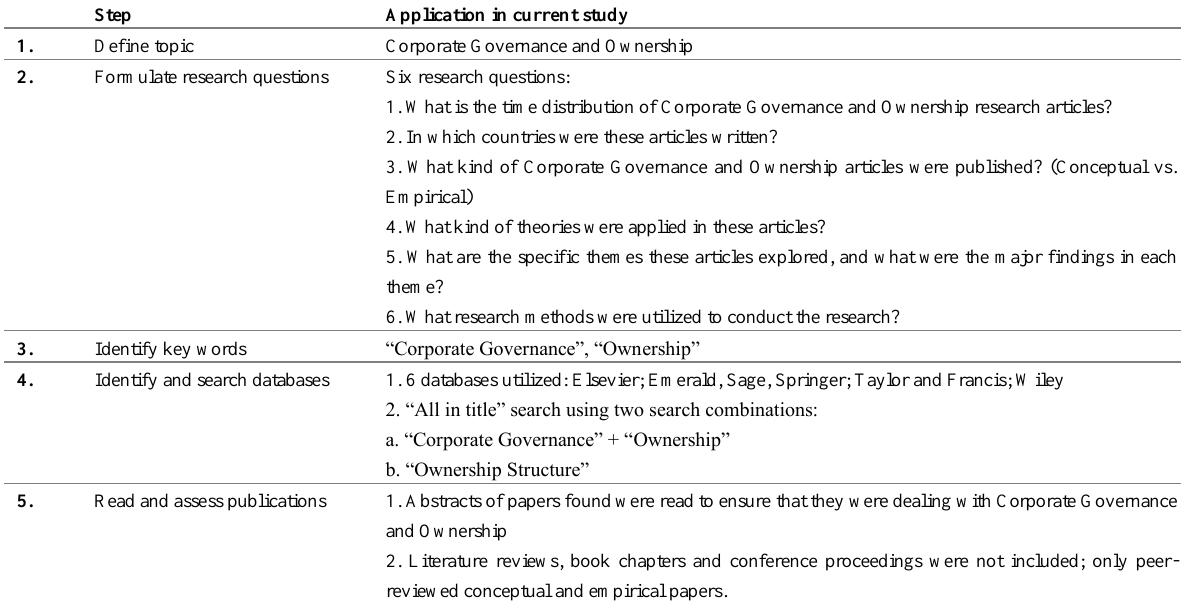
Table 1: Description and application of SQAT